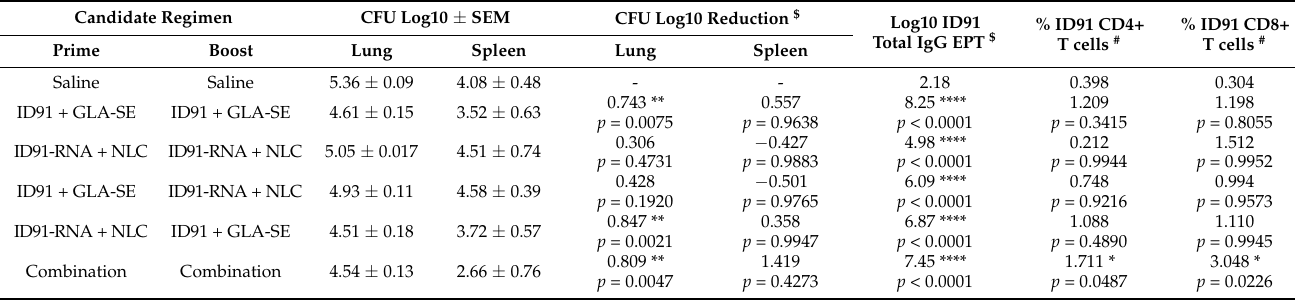
Figure 3. Single immunization with repRNA vaccine is moderately immunogenic and affords prophylactic protection. ( A ) Experimental schematic showing splenocytes from cohorts of saline (grey circles), ID91 + GLA ‐ SE (red squares) or ID91 repRNA + NLC (blue triangles) immunized mice 6 weeks post ‐ vaccination were stimulated with ID91 ex vivo and evaluated by intracellular cytokine staining flow cytometry including ( B ) percentage of CD4 + CD44 cytokine ‐ producing T cells as well as ( C ) percentage of CD8+ CD44+ cytokine ‐ producing T cells after medium subtraction. n = 4 per group. ( D ) Plasma was evaluated 6 weeks post ‐ vaccination for total IgG responses to fusion antigen ID91 and its components, Log10 endpoint titer (EPT) is shown. n = 4 per group. ( E ) Pulmonary bacterial burden Log10 CFU 3 weeks post ‐ LDA challenge with M.tb H37Rv. n = 7 per group, mean value and SEM shown with Y-axis beginning at 5.5 Log10 CFU. Asterisks represent a statistically significant difference from saline using One-way ANOVA with Dunnett’s multiple-comparison test. All data are representative of two independent repeated experiments. * p < 0.05, ** p < 0.01, *** p < 0.001 and **** p < 0.0001. Table 2. Immunogenicity and Efficacy using Prime-Boost